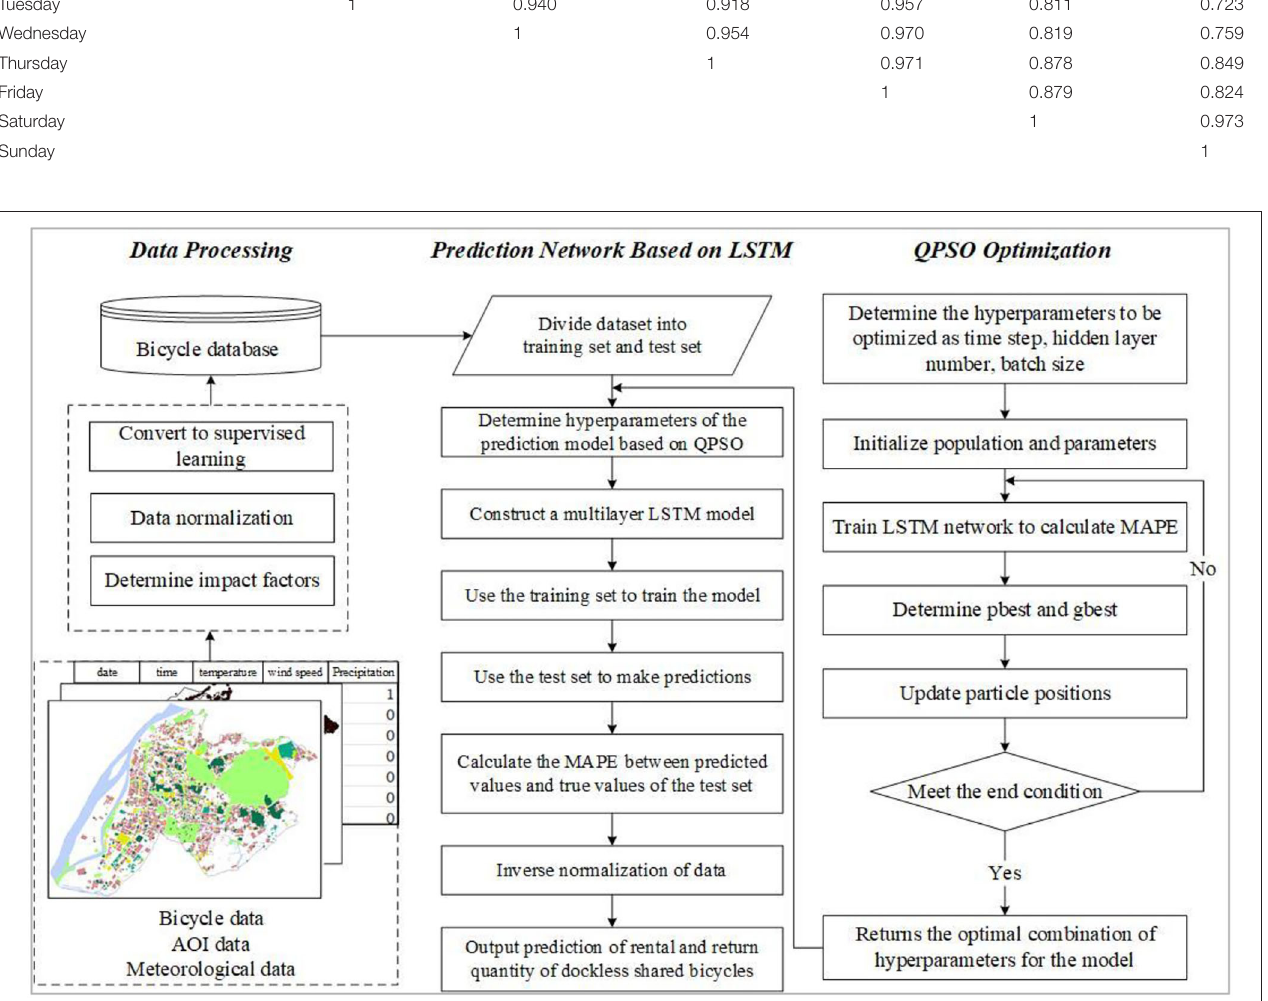
FIGURE 3 | QPSO-LSTM